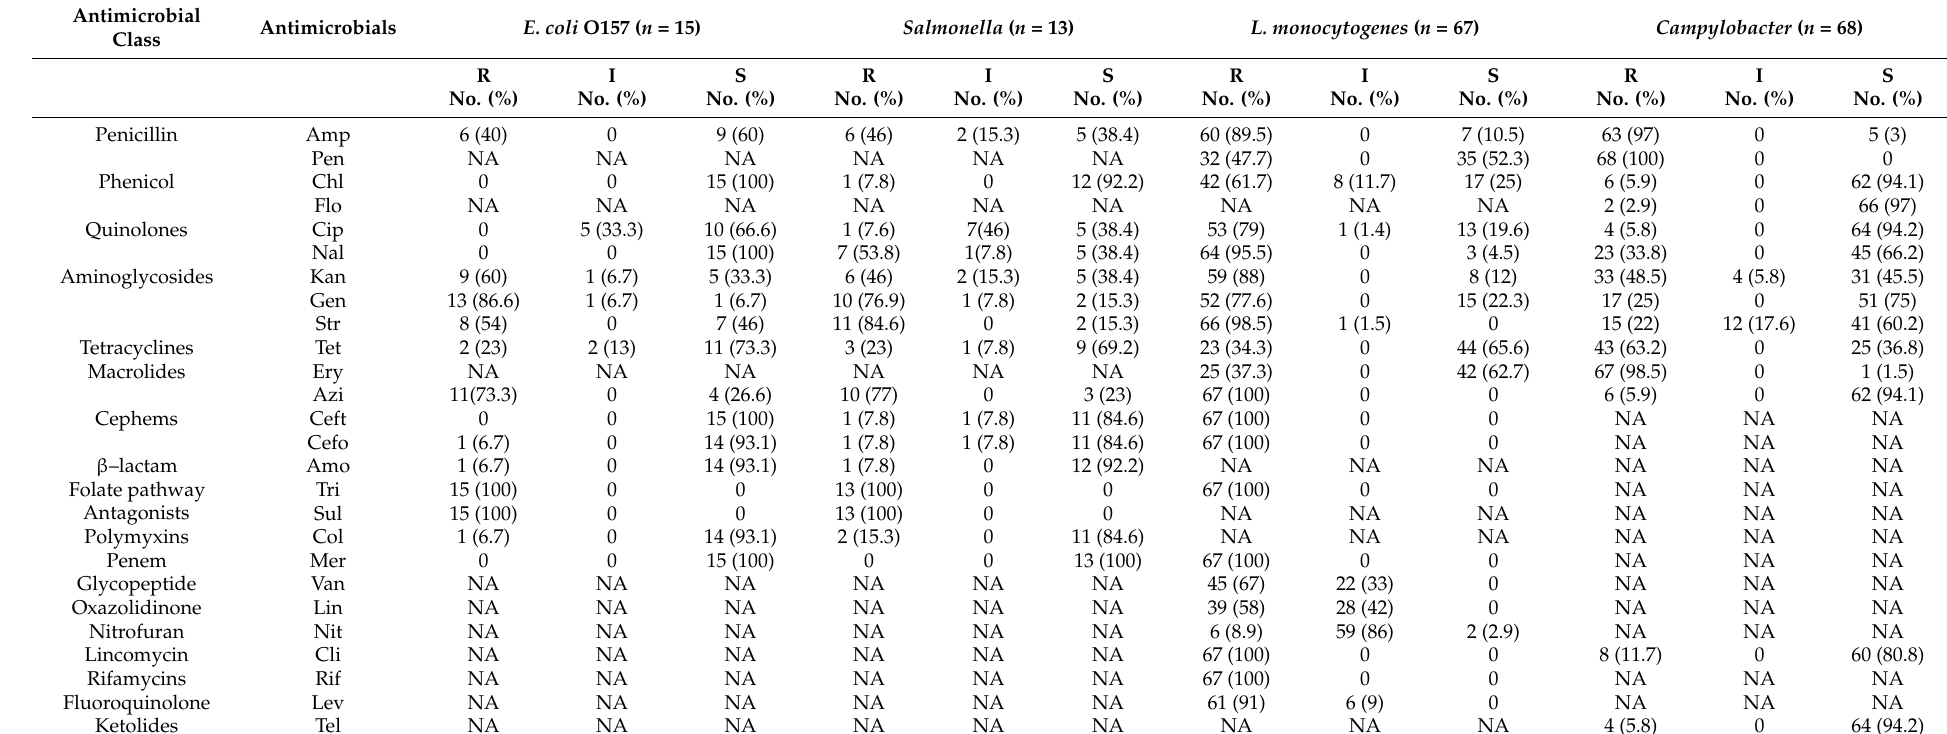
Table 3. Antimicrobial resistance profile of the foodborne